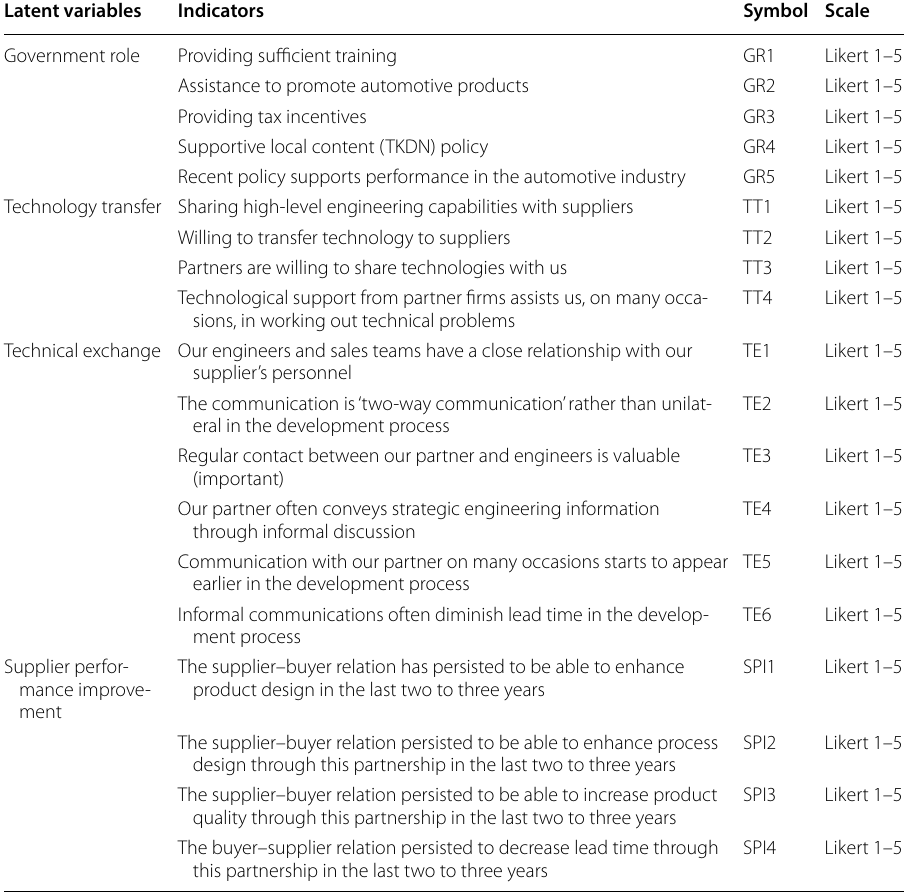
Table 1 Indicator variables. Source Adopted question from previous research (Kotabe et al. 2003) and based on preliminary interview with automotive players in Jabodetabek, Indonesia